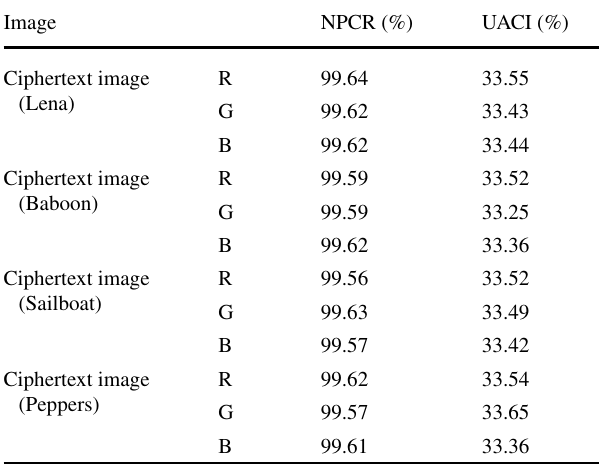
Table 12 The NPCR and UACI between two ciphered images